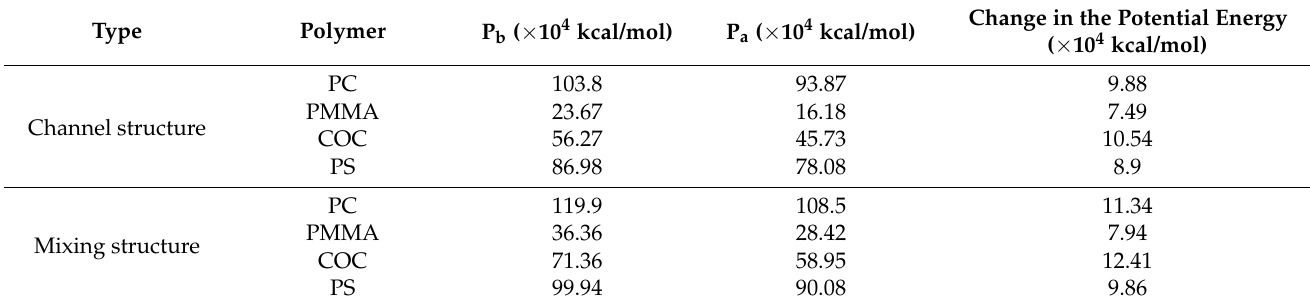
Table 3. Changes in the potential energy of four polymers on different structural mold